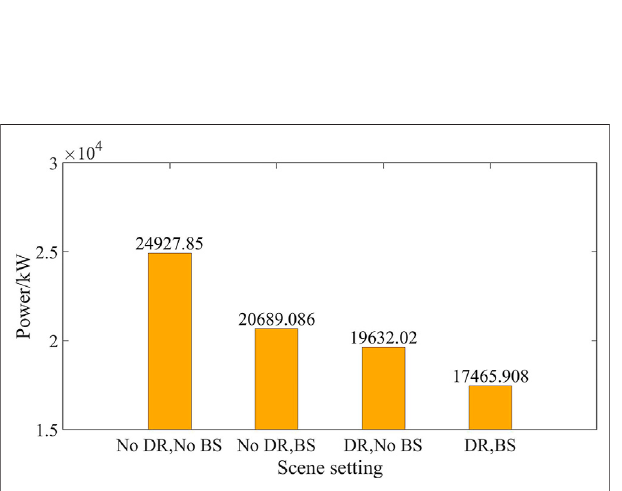
FIGURE 12 | Residual heat dissipation under various